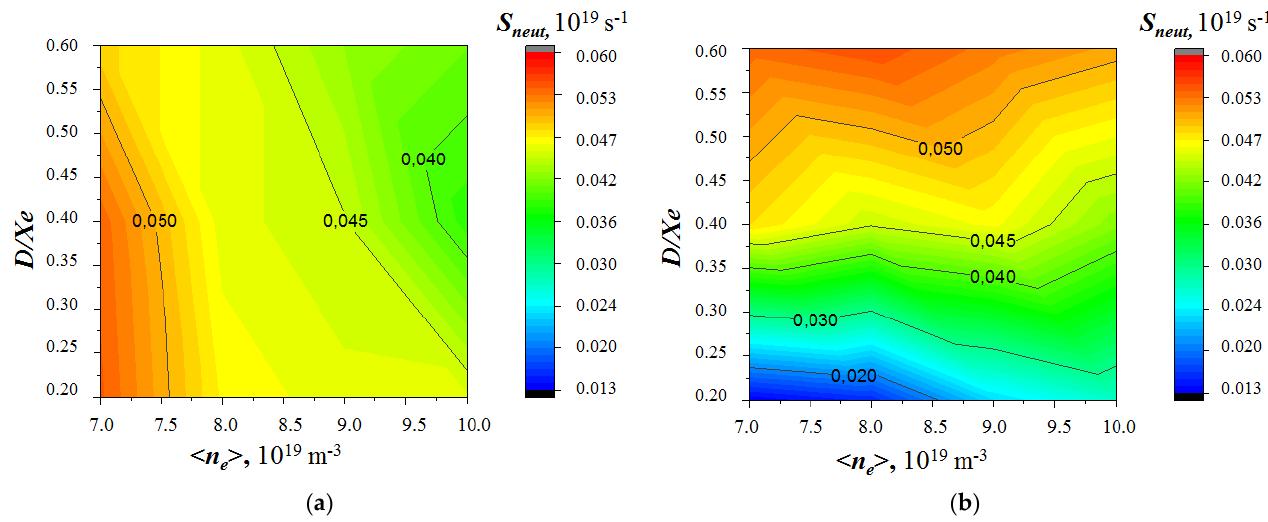
Figure 5. Neutron flux S neut as a function of the n e and D/ χ e parameters for the ( a ) D+T and ( b ) D beams. The scale on the Figure 5. Neutron intensity S neut as a function of the n e and D/ χ e parameters for the ( a ) D + T and ( b ) D beams. The scale right shows the correspondence of the color and S neut values. on the right shows the correspondence of the color and S neut values.